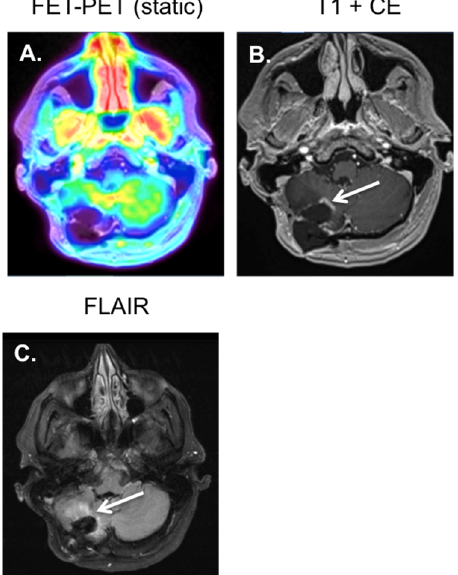
Figure 4. Patient with a GBM in the right cerebellar hemisphere, after resection and concurrent radiotherapy and temozolomide treatment. Three months after treatment, an irregular nodular contrast enhancement is visible on the MRI near the edges of the resection site (see white arrow image ( B )), with gliotic changes around this area on the FLAIR (see white arrow image ( C )). The 18 F ‐ FET ‐ PET ( A ) only showed a low tracer uptake in the area of contrast enhancement (TBR max = 1.4 < 2.0), which was interpreted as radio ‐ necrosis.